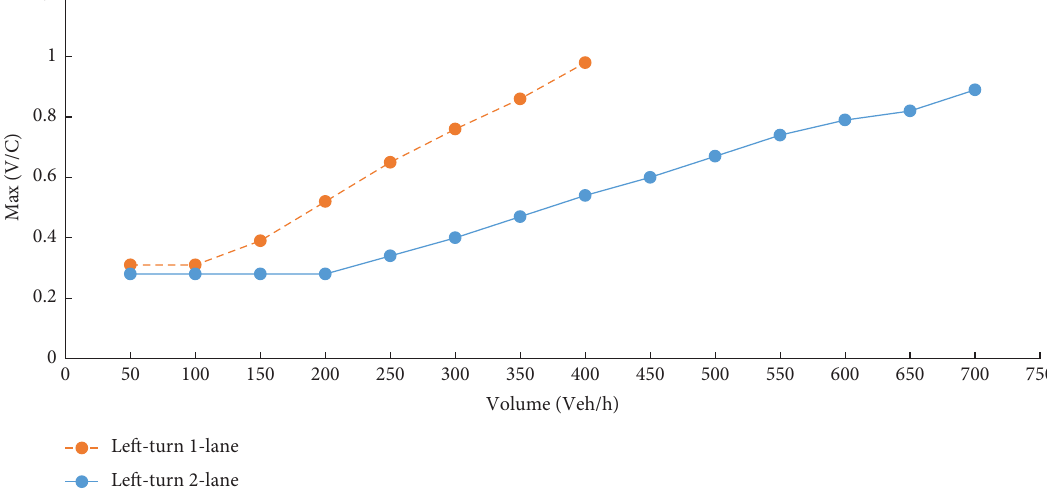
Figure 12: Comparison of changing single to dual left-turn lane on volume to capacity (v/c)